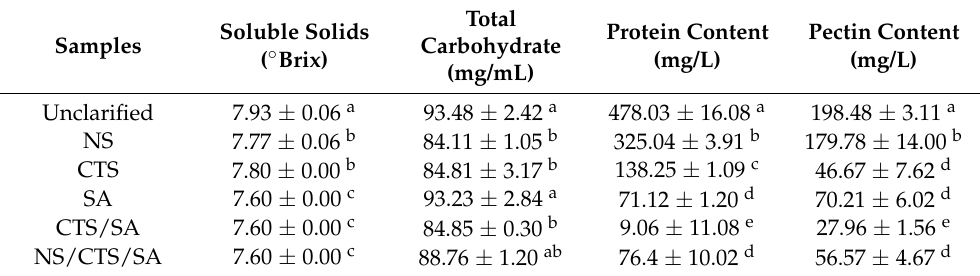
Table 2. Effects of different clarification methods on soluble solids, total carbohydrate, protein,